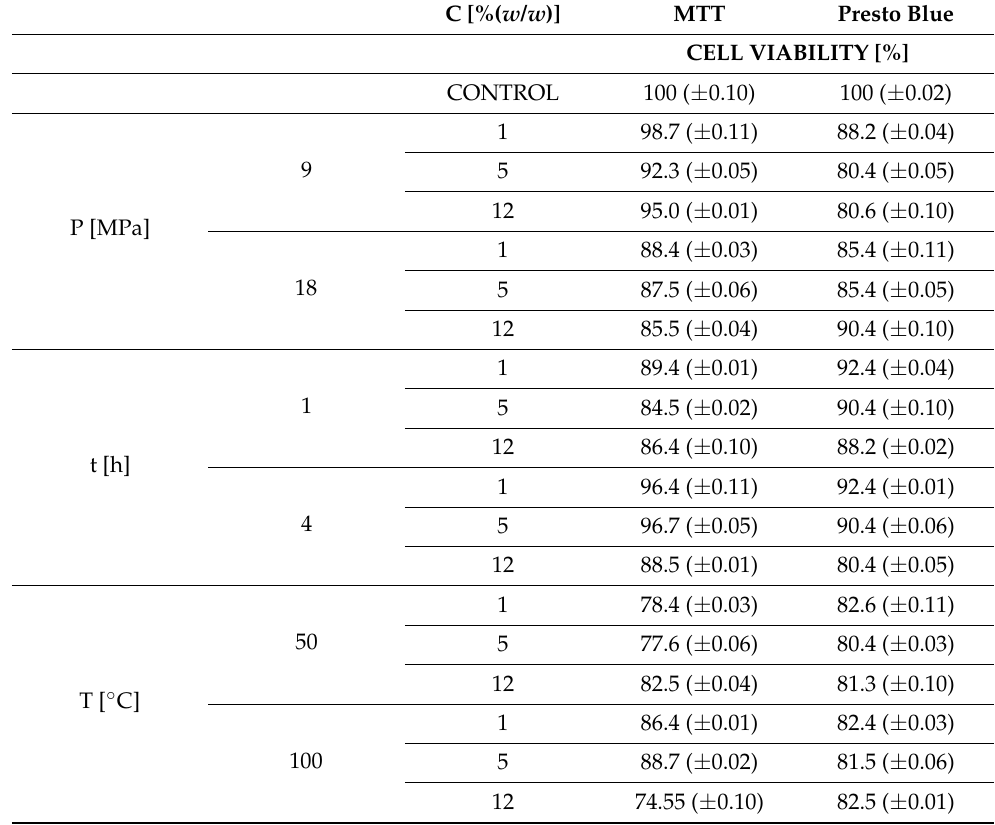
Table 4. Influence of the concentration of the applied additive nC and the foaming process conditions: pressure P sat , temperature T sat , saturation time t sat on the viability of